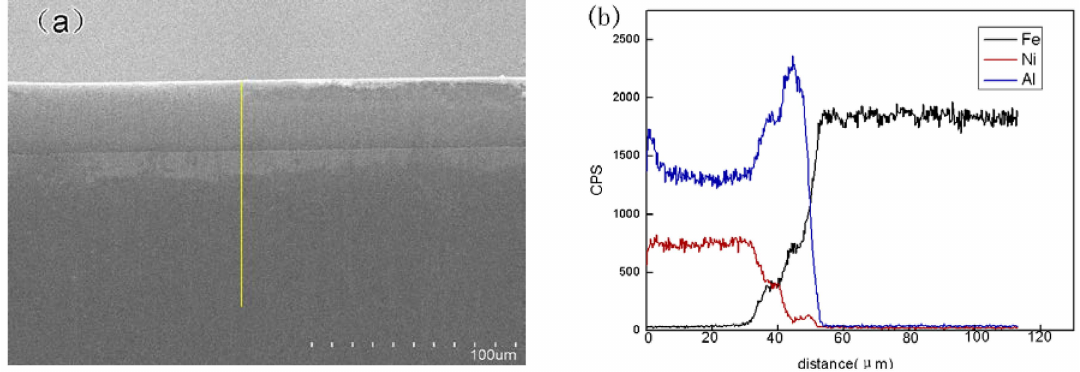
Figure 3. Cross section ( a ) and composition ( b ) of a line scan of the Ni 2 Al 3